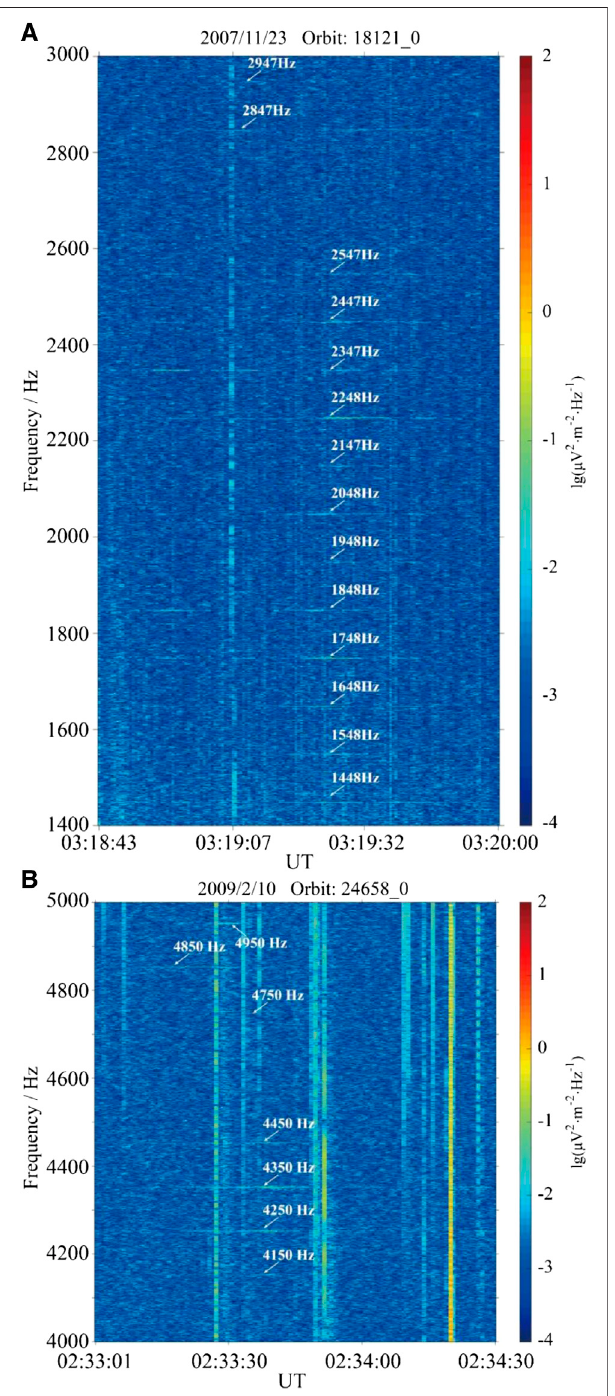
FIGURE3| TypicalPLHRoccurrencesoveranAC-to-AC substation (A) and an AC-to-DC substation (B) .